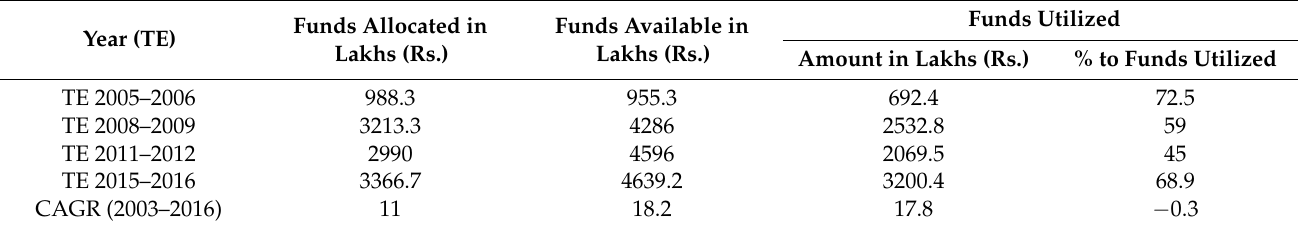
Table 3. Funds allocated under the Horticulture Mission for North East and Himalayan states (HMNEH) program, Uttarakhand. Year